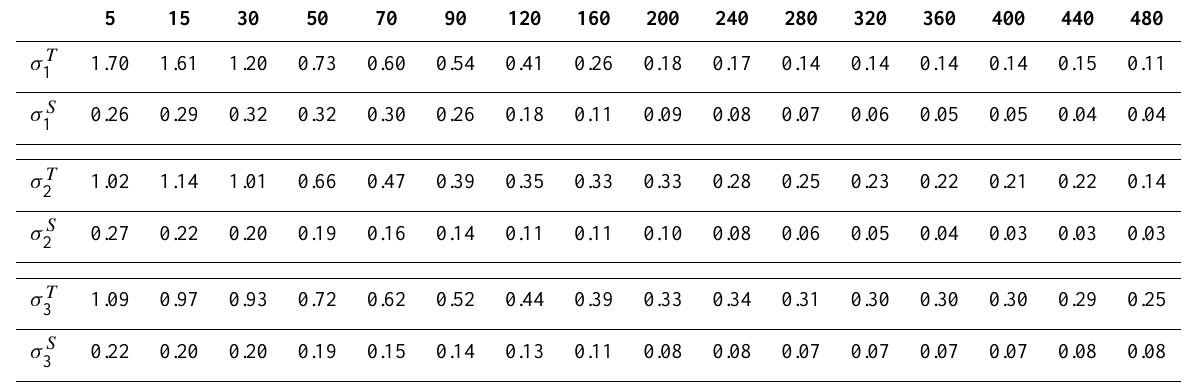
Table 2. The variance of temperature ( ◦ C) and salinity (psu) at different depths for the 480m surface layer in three different areas of the first line of the table is given in meters